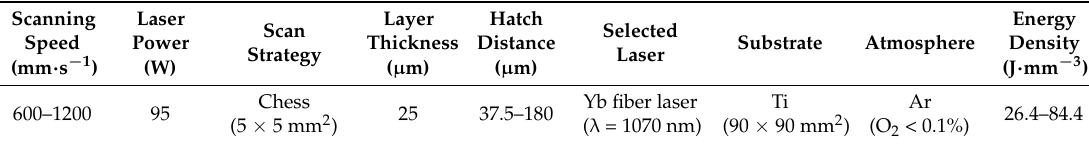
Table 2. Process parameters for Zr-1Mo alloy